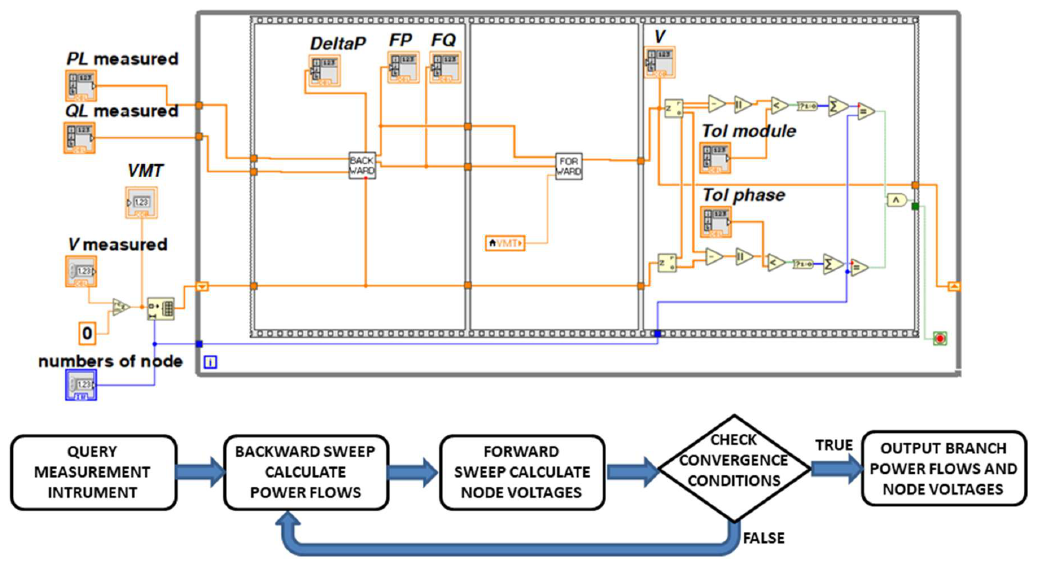
Figure 2. Block diagram for the power flow calculation.